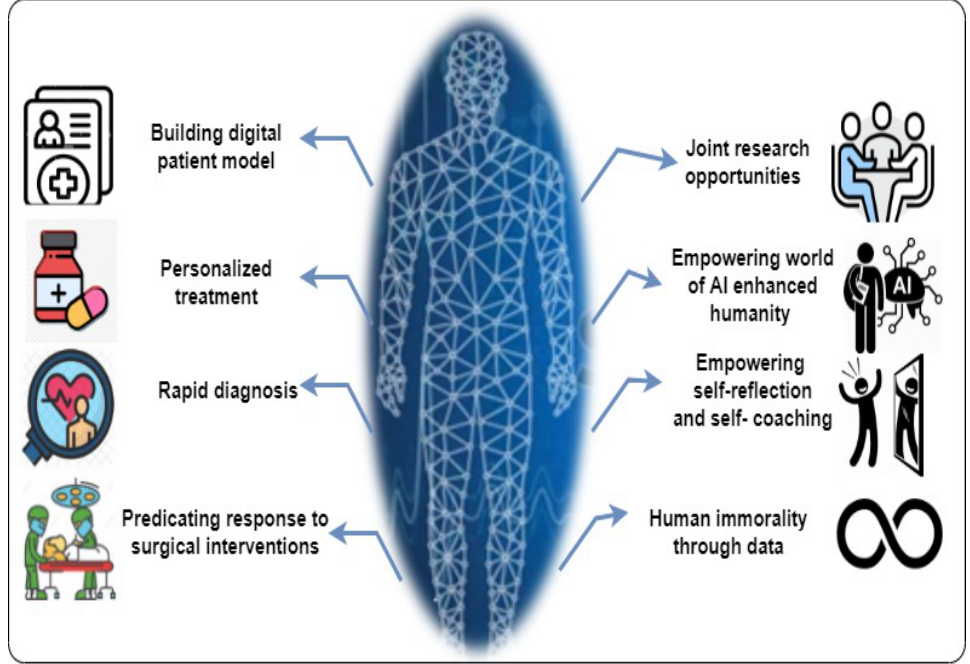
Figure 6. The benefits of using a personal digital